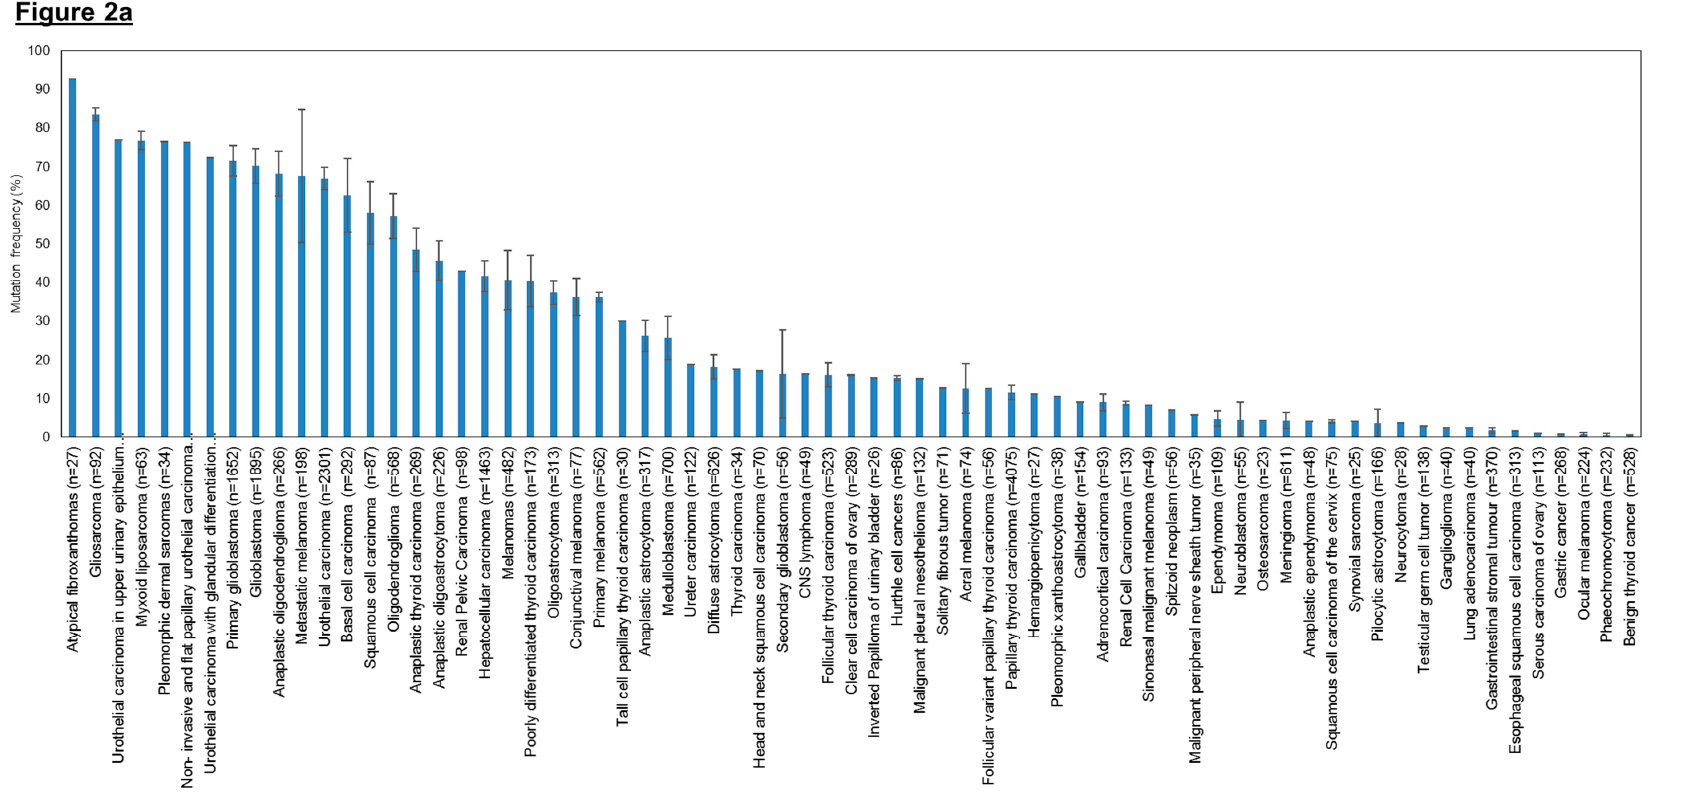
Figure 2. Cont Figure 2. Cont.